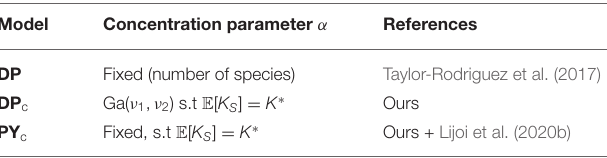
TABLE 1 | Specification of concentration parameter α for the DP , DP c ,